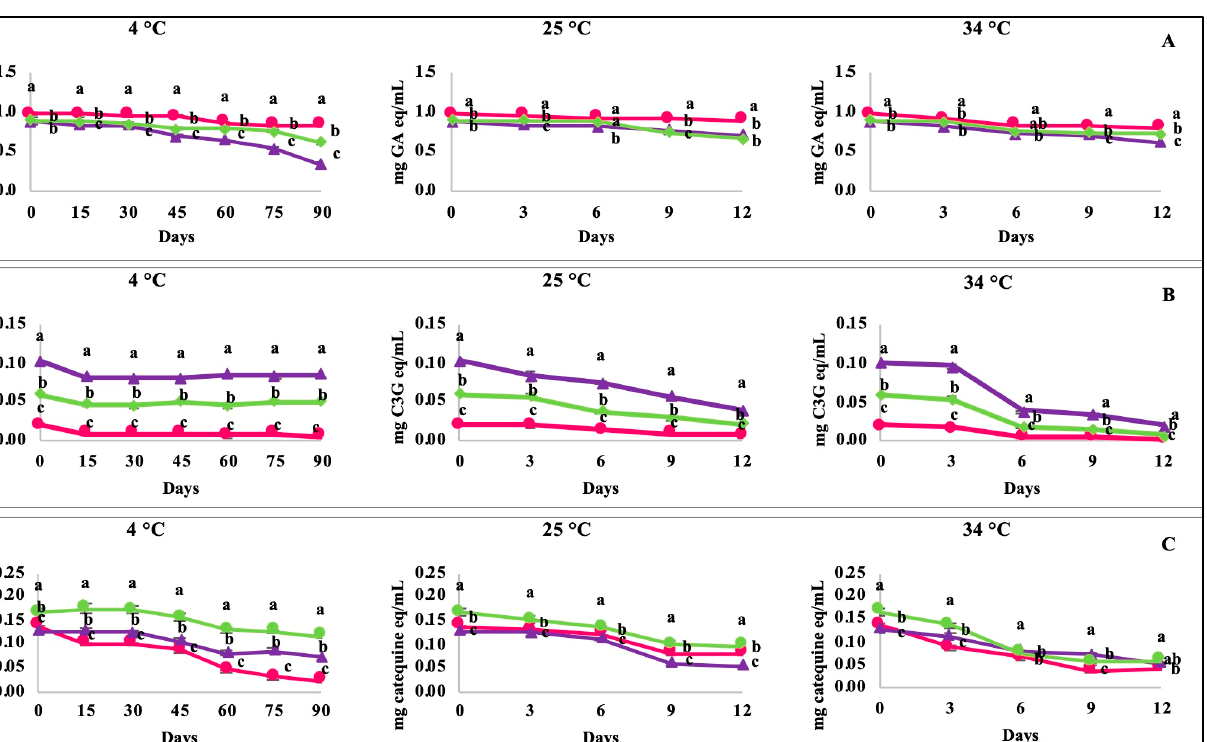
Figure 2. Degradation of polyphenolic compounds of the berry-based beverages at 4 ◦ C, 25 ◦ C, and 34 ◦ C in storage. ( A ) Total phenolic compounds; ( B ) total monomeric anthocyanins; ( C ) total proanthocyanidins. Circles ( • ): strawberry beverage; triangles ( (cid:78) ): blueberry beverages; diamond ( (cid:7) ): strawberry–blueberry beverage. Data are expressed as the mean ± standard deviation of three replicates. Different letters on the same day indicate significant ( p < 0.05) differences between samples by Tukey’s